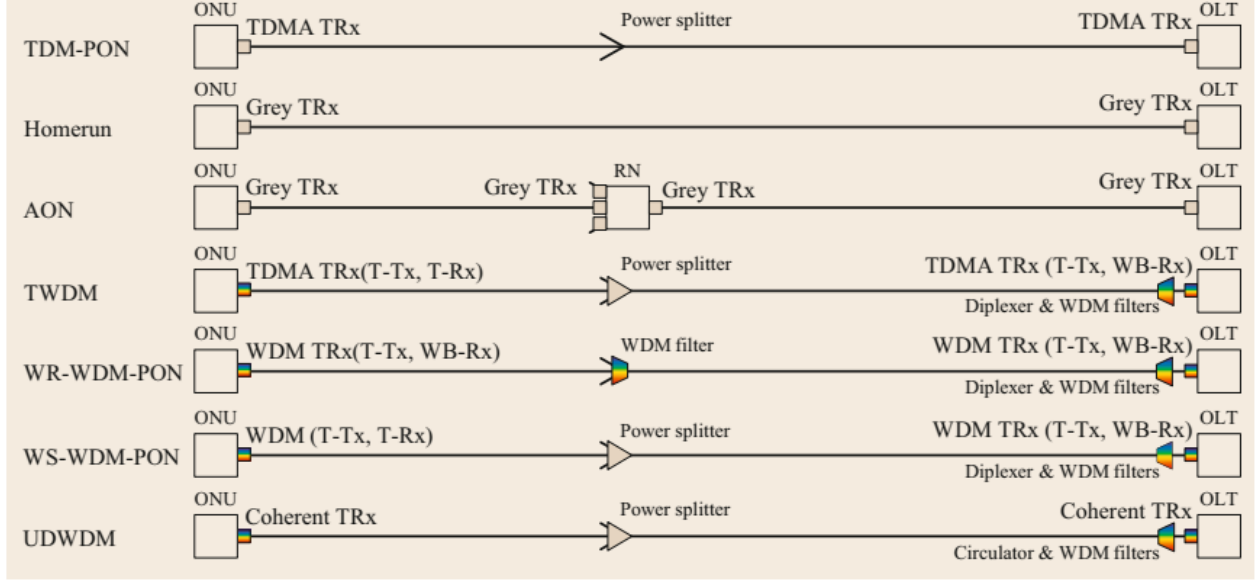
Figure 32. Architectural illustration of various access variants [53].